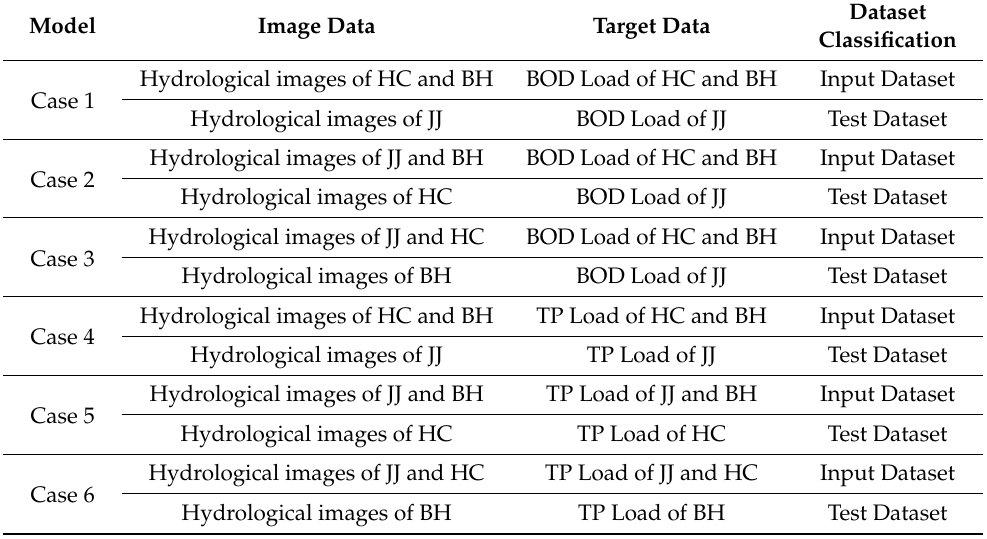
Table 2. Dataset